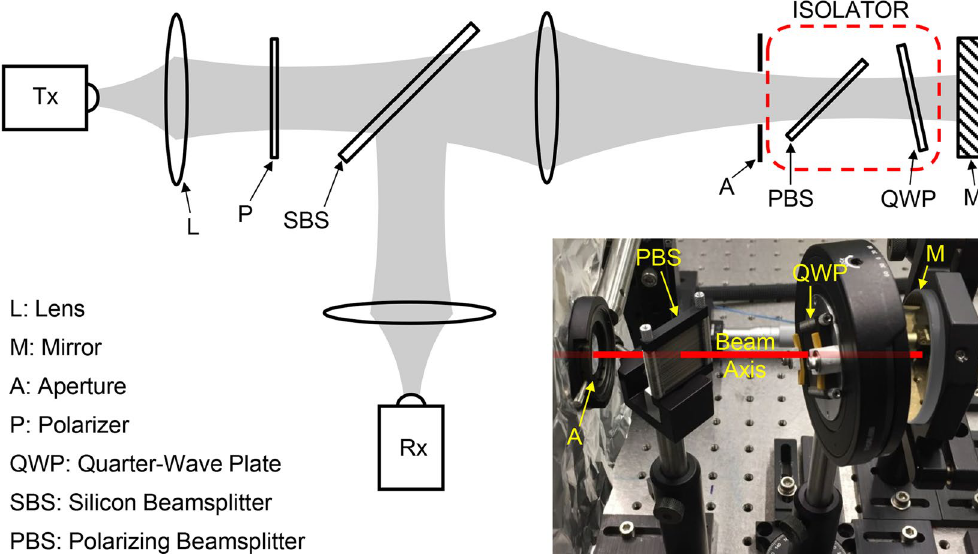
Figure 6. Schematic of the experimental setup used to investigate the isolator. The isolator consists of the PBS combined with a QWP as shown by the red dashed enclosure. A photographic view of the isolator is shown inset. The input polarization is vertical (and perpendicular to the plane of the paper). A gold mirror was used to create the back-reflection, and a silicon beamsplitter was used to tap it off to the receiver. The PBS is at 45° incidence by design, and the QWP is at a 12° incidence to eliminate reflections originating from it.